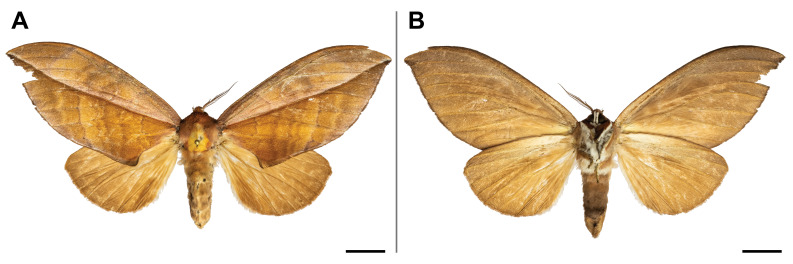
Brachychira
punctulata Kiriakoff, 1966. A. dorsal view; B. ventral view. The scale bar represents 1 cm.